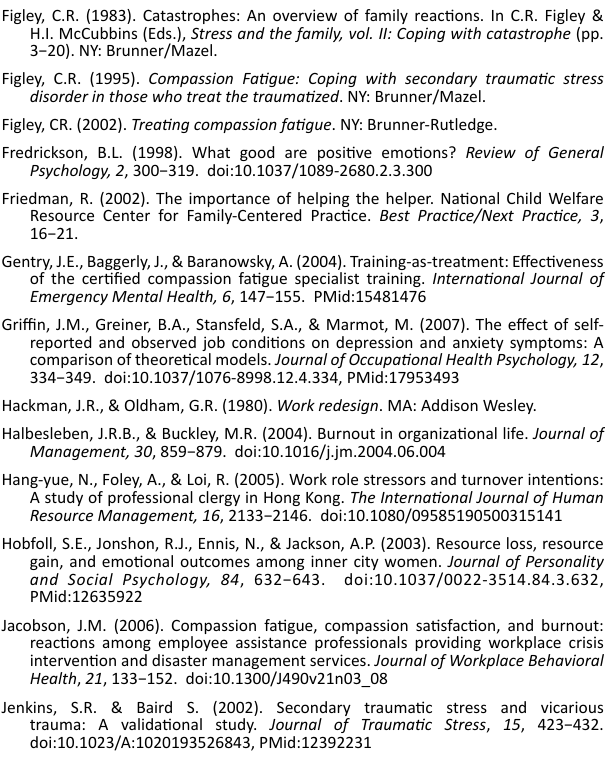
Figley, C.R. (1983). Catastrophes: An overview of family reactions. In C.R. Figley & H.I. McCubbins (Eds.), Stress and the family, vol. II: Coping with catastrophe (pp. 3−20). NY: Brunner/Mazel. Figley, C.R. (1995). Compassion Fatigue: Coping with secondary traumatic stress disorder in those who treat the traumatized . NY: Brunner/Mazel. Figley, CR. (2002). Treating compassion fatigue . NY: